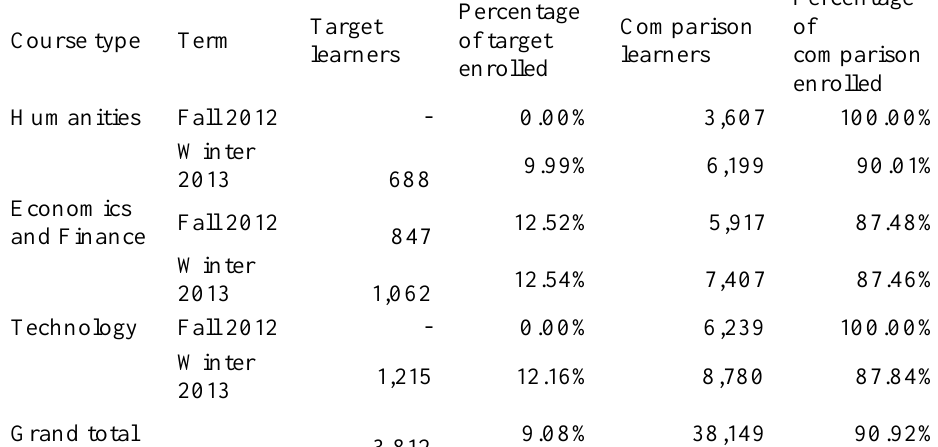
Representation of Target and Comparison Groups by